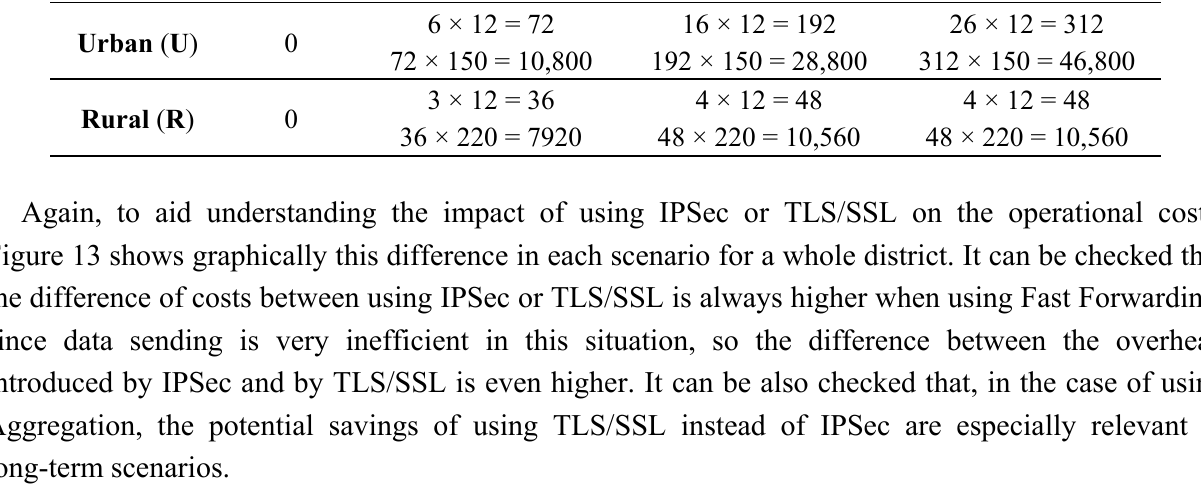
| – C | ) S IPSec S TLS/SSL